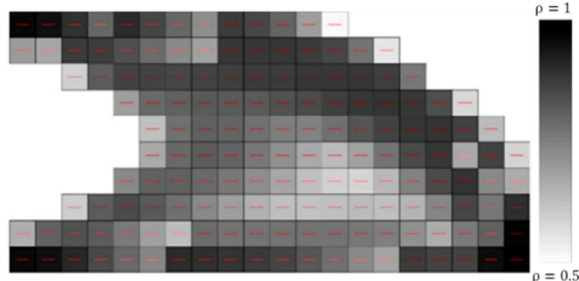
Figure 13. Topology result for Case 2 (front view). Elements with ρ e ≤ 0.5 are not shown.